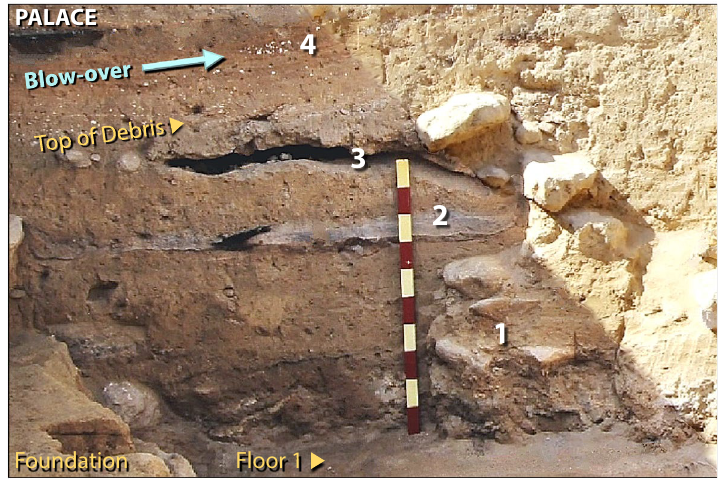
Figure 3. Destruction of the multi-storied palace. Photo showing jumbled rubble of four-story Palace atop Floor 1. Remains of debris from upper stories are labeled as follows. #1 represents broken mudbricks and debris from shattered upper walls. #2 and #3 are voids and layers formed when trapped textiles (rugs and tapestries) burned, leaving only fibrous ash and carbon. ‘Blow-over’ (in blue) is composed of windblown, laminated deposits that sealed the ruined structure for ~ 3600 years, beginning at the time of destruction. #4 marks fragments of white limestone plaster (CaCO 3 ) mixed with carbonate spherules from the palace walls and ceiling. Scale stick has 10-cm markings.